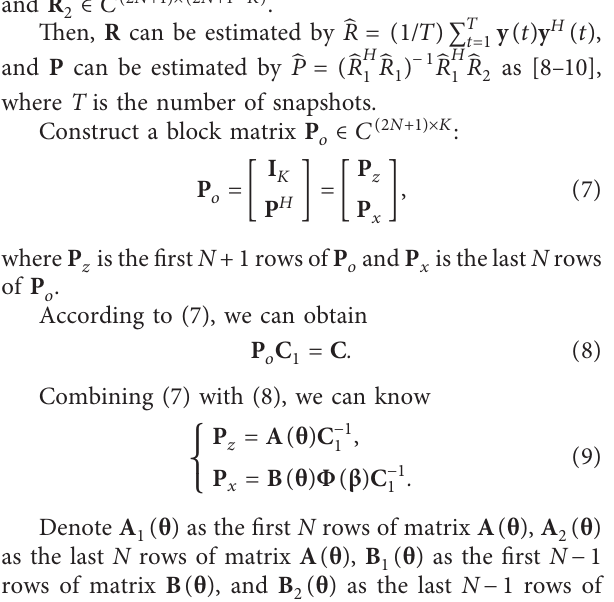
Figure 3: Two uniform parallel linear arrays [8,